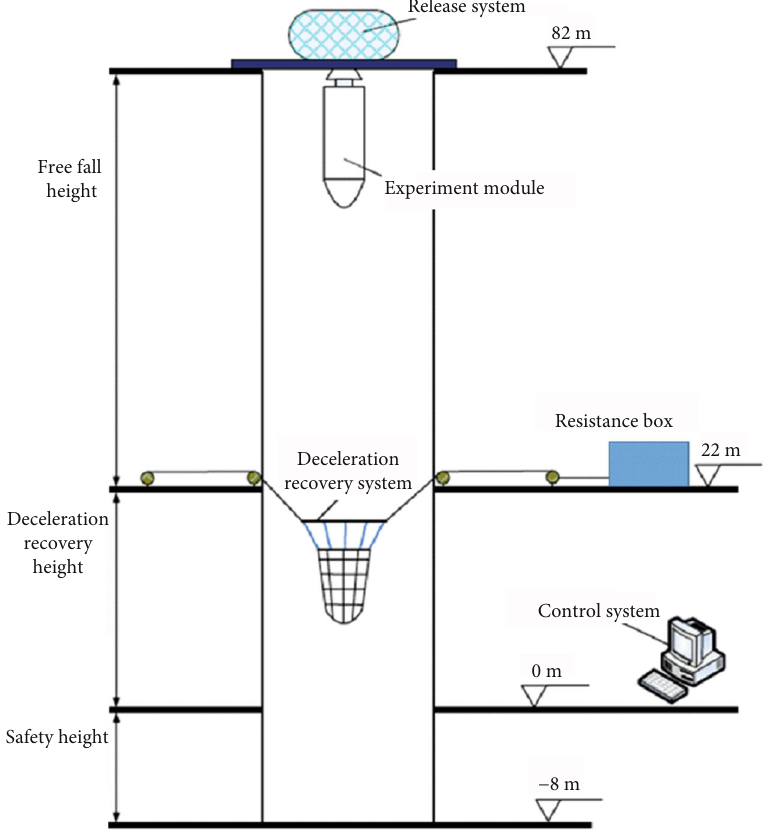
Figure 1: Drop tower test